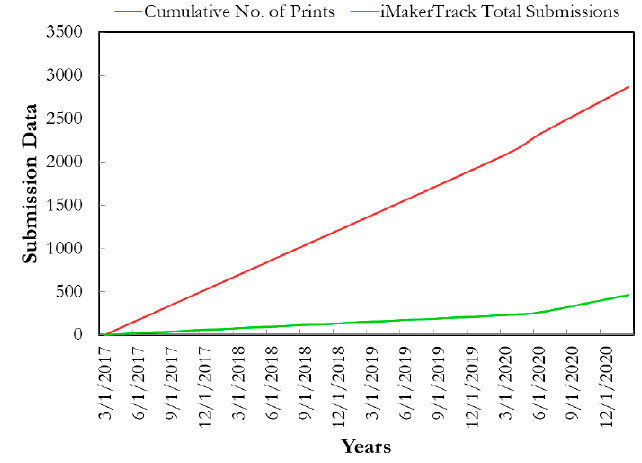
Figure 13. Usage statistics of the iMakerSpace.